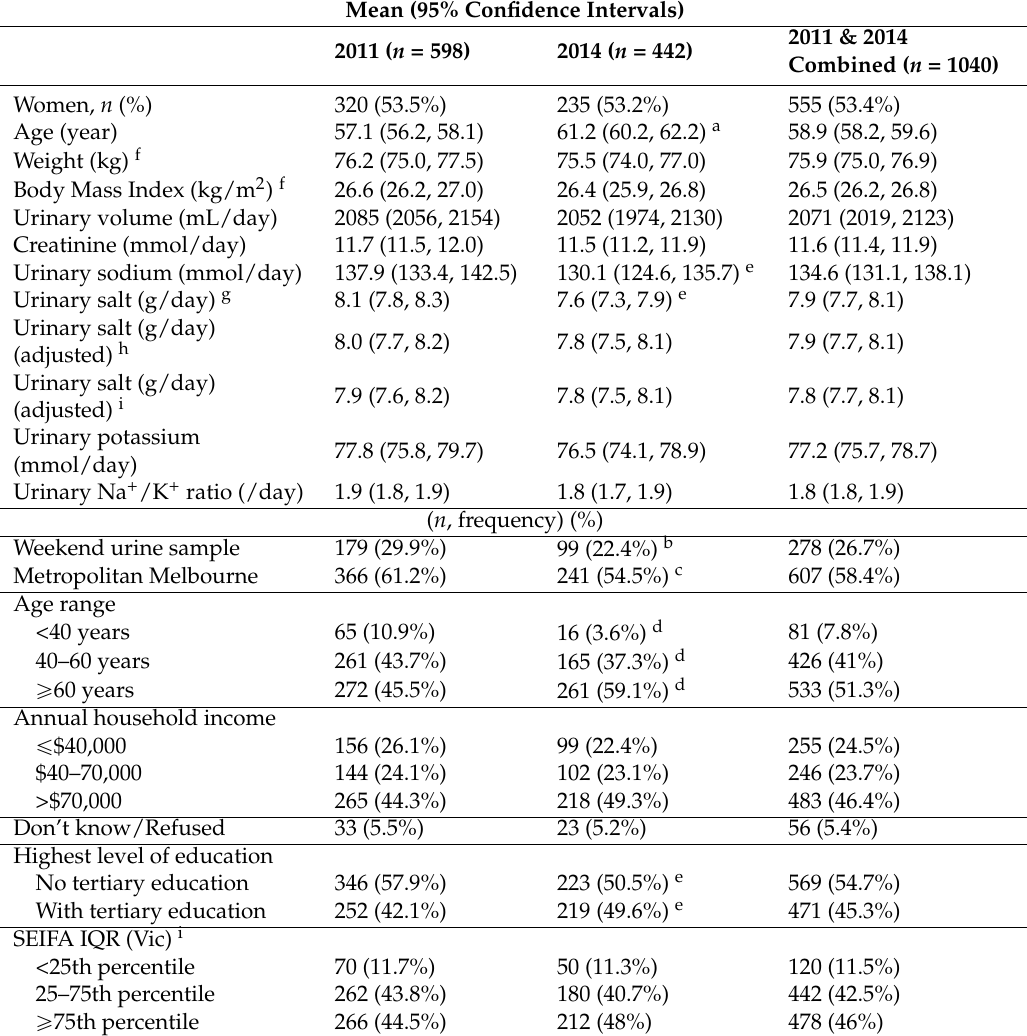
Table 1. Demographic characteristics (2011,